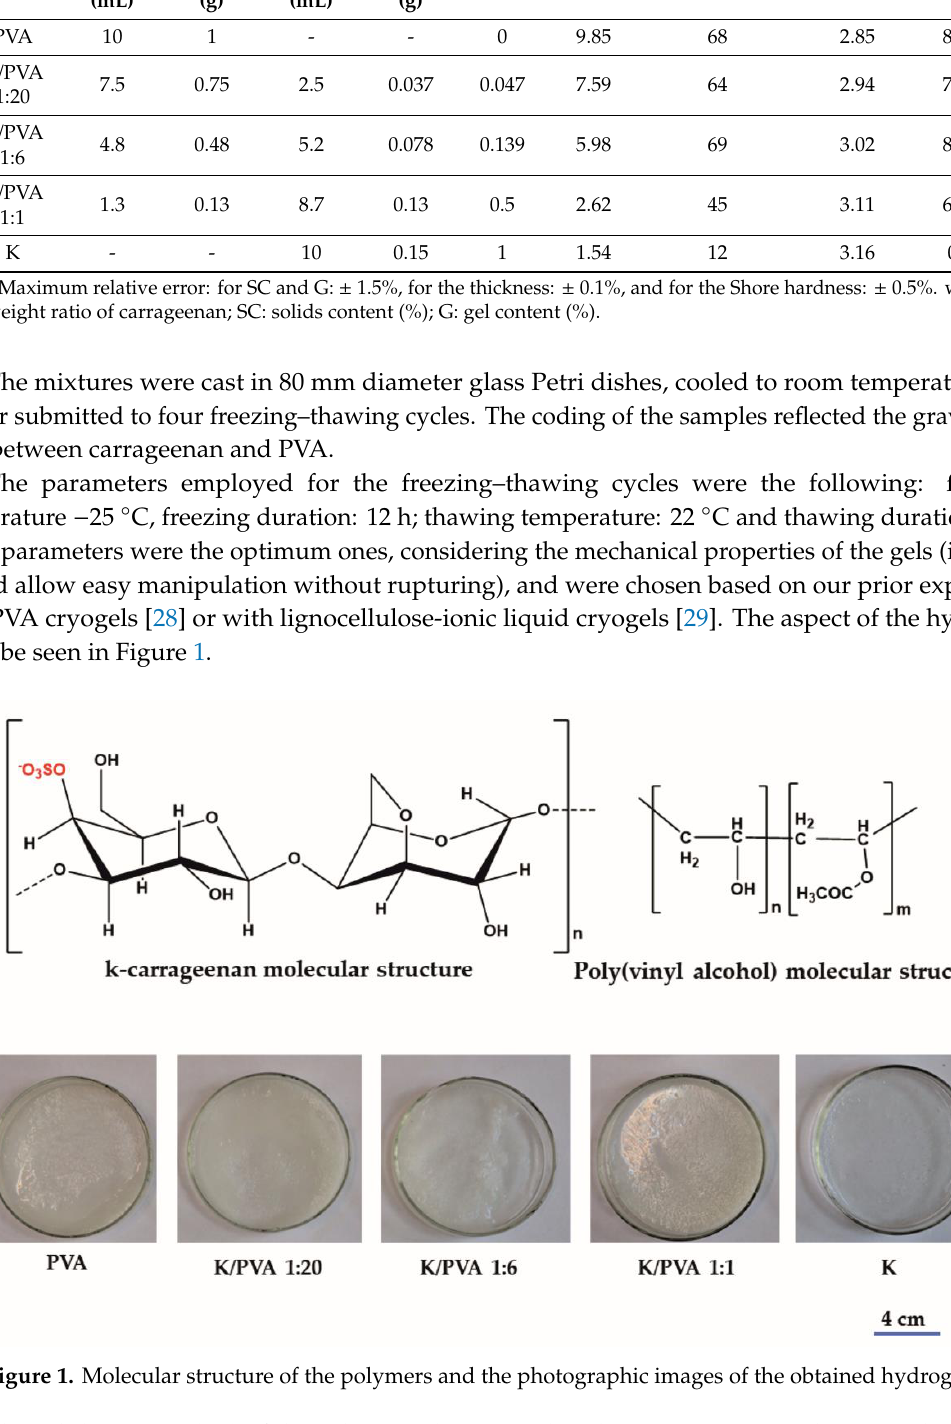
Table 1. Characteristics of the obtained hydrogels. Poly (vinyl alcohol) (PVA), κ -carrageenan (CAR). Sample Code